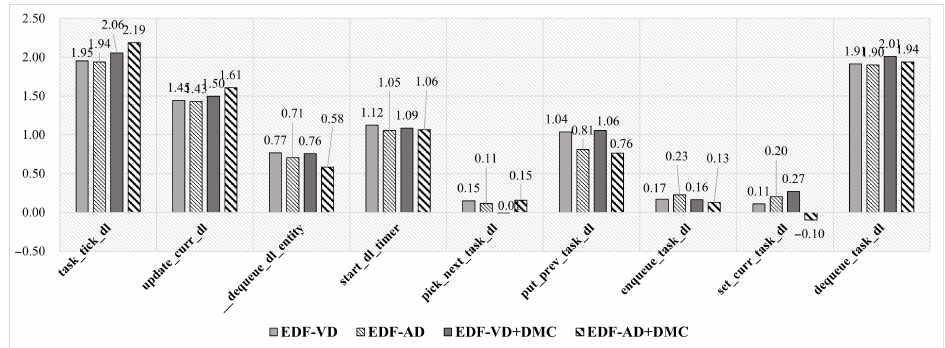
Figure 10. Ftrace: scheduling overhead comparison in graphs.